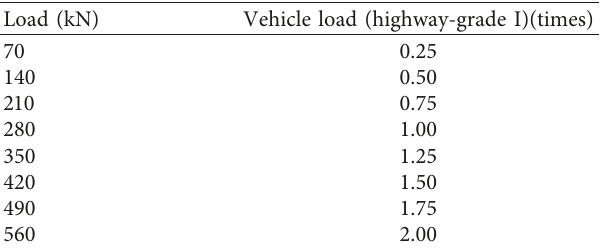
Figure 6: Vehicle loading position: (a) direction horizontal to the bridge and (b) direction vertical to the bridge. Table 1: Load and corresponding designed vehicle